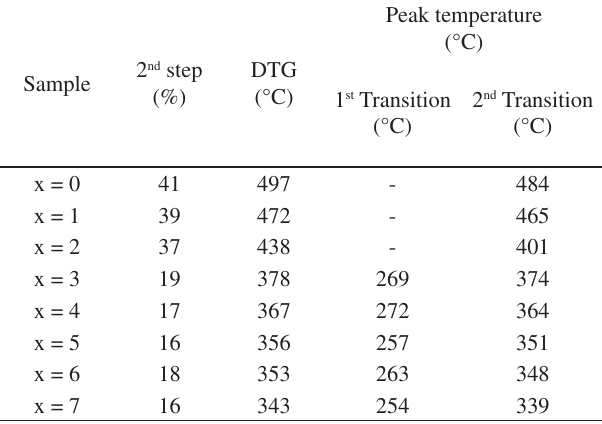
Co Sb O (x = 0 - 7). 7-x x 2 12